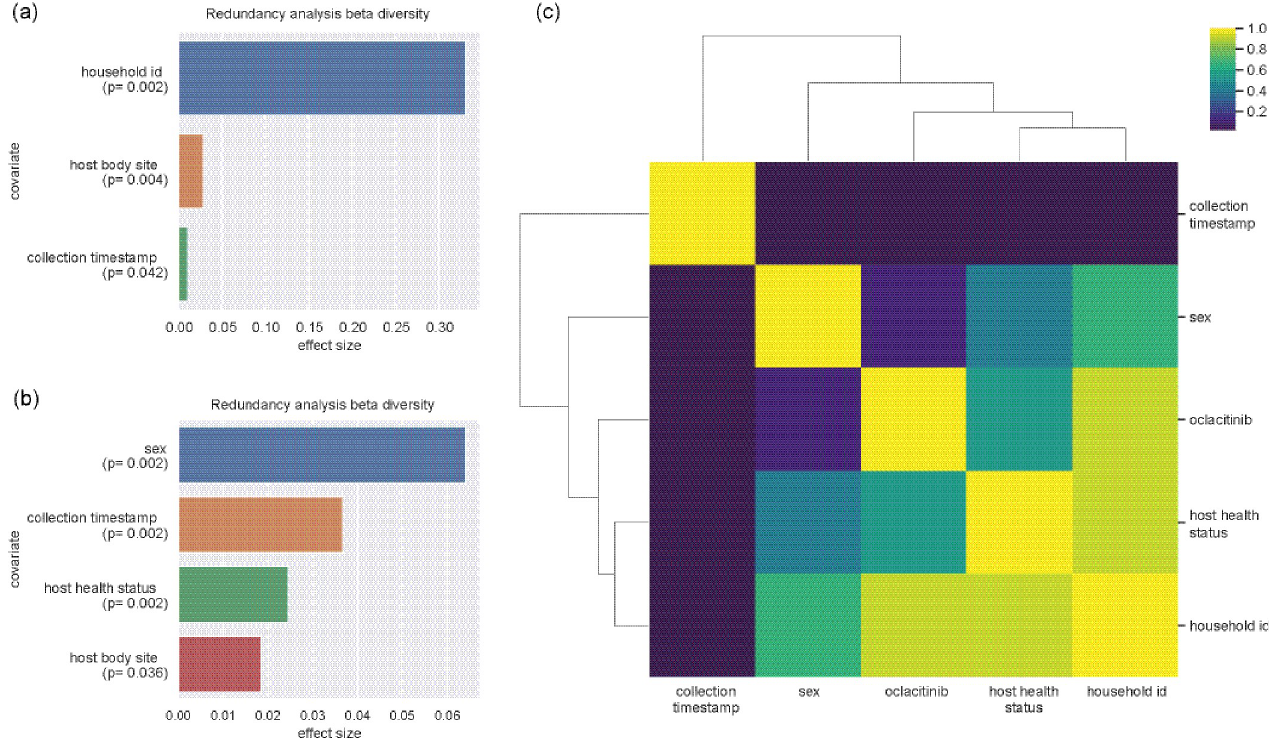
Fig 7. Forward step redundancy analysis (RDA) indicating the impact of metadata on beta diversity analysis including all studied dogs and body skin sites (a; b, excluding the factor household) and heatmap showing the interrelation of metadata (c).